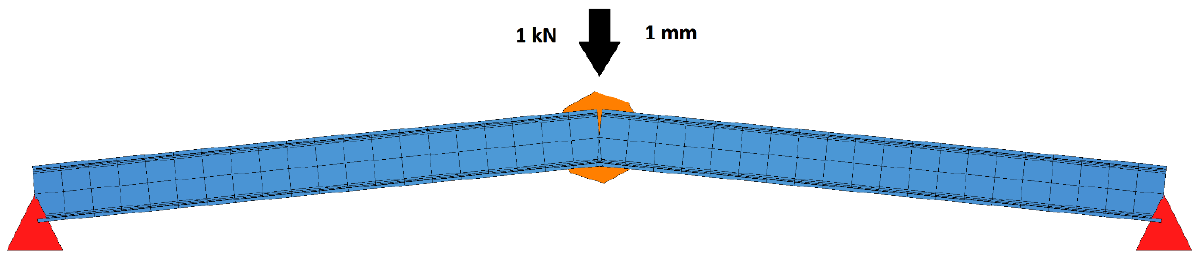
Figure 3: The model of von Mises